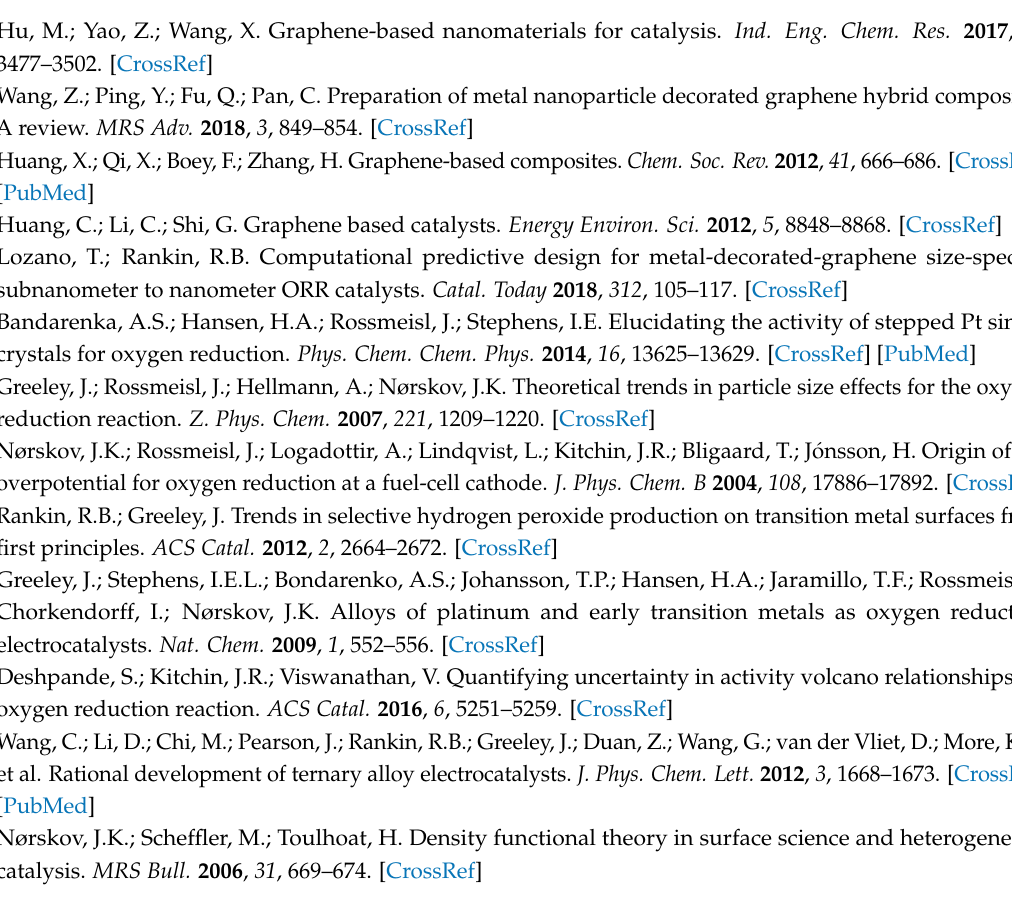
Figure SI1: Volcano Plot analysis for Oxygen Reduction Reaction (ORR) activity at solvent correction value of − 0.45 eV: Zoomed Level Detail per Panel , Figure SI2: Volcano Plot analysis for Oxygen Reduction Reaction (ORR) activity at solvent correction value of − 0.35 eV: Zoomed Level Detail per Panel , Figure SI3: Volcano Plot analysis for Oxygen Reduction Reaction (ORR) activity at solvent correction value of − 0.20 eV: Zoomed Level Detail per Panel , Figure SI4: Volcano Plot analysis for Oxygen Reduction Reaction (ORR) activity at solvent correction value of − 0.00 eV: Zoomed Level Detail per Panel